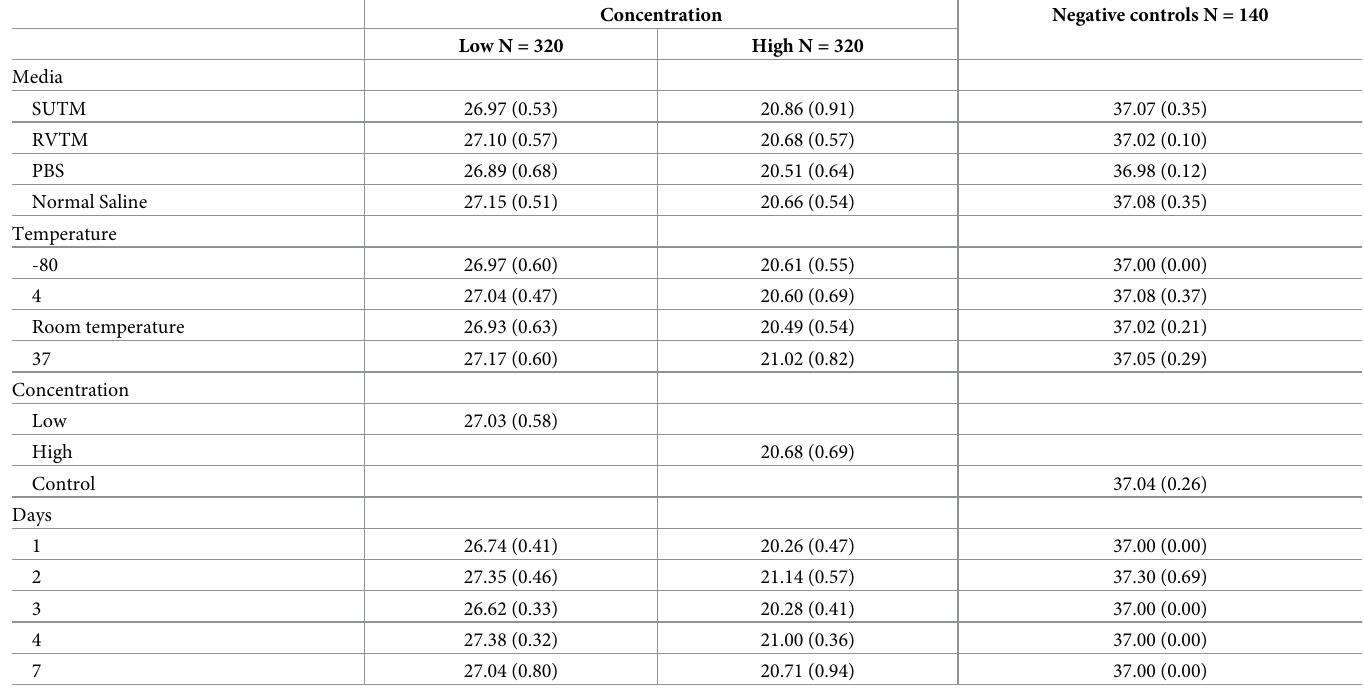
Table 1. Mean Ct values for the high and low concentrations and negative